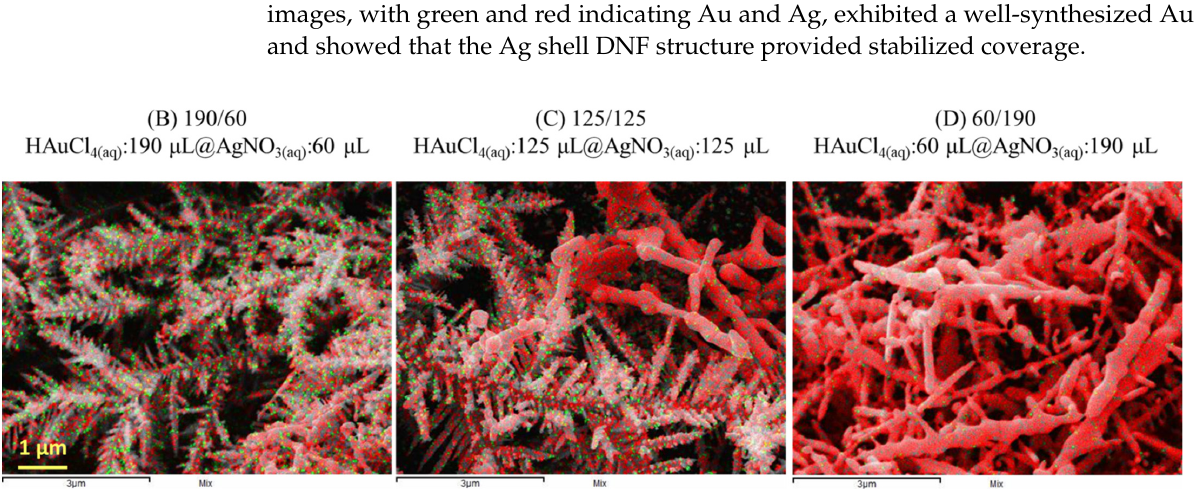
Figure 4. EDX mapping of samples (B–D) in Figure 3. Green indicates Au, and red indicates Ag. As Figure 5a indicates, the Au@Ag-DNFs/Si with various Au/Ag ratios could be estimated using the EDX measurement data. The peaks of Au and Ag were 2.16 keV and 3.0 keV, respectively. The Au (Ag) peaks intensity of samples (A–E) (see Figure 3) decreased (increased) with the Au/Ag ratio decrease, respectively. As illustrated in Figure 5b, the Si and O signals were small and filtered out to estimate the Au and Ag signal ratio. Ag+ ratio peaks increased as the proportion of Ag + increased during synthesis in all samples